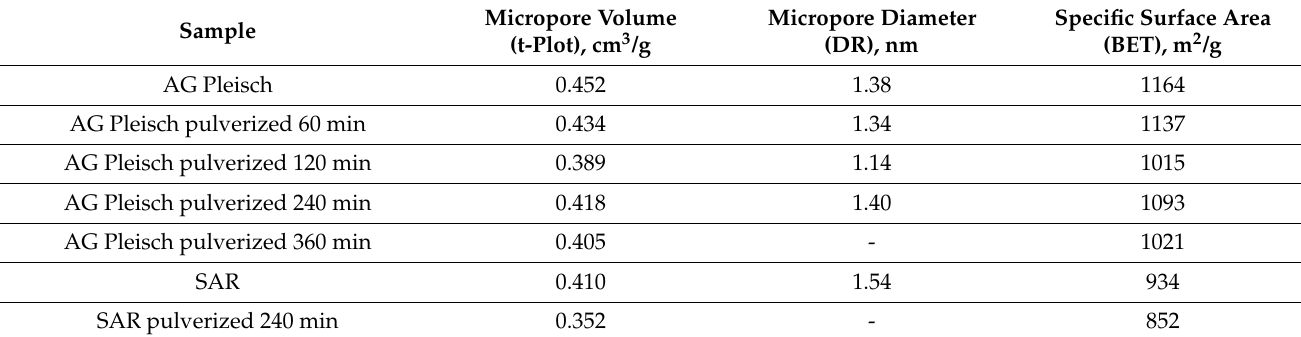
Table 1. Textural and adsorption properties of activated carbon